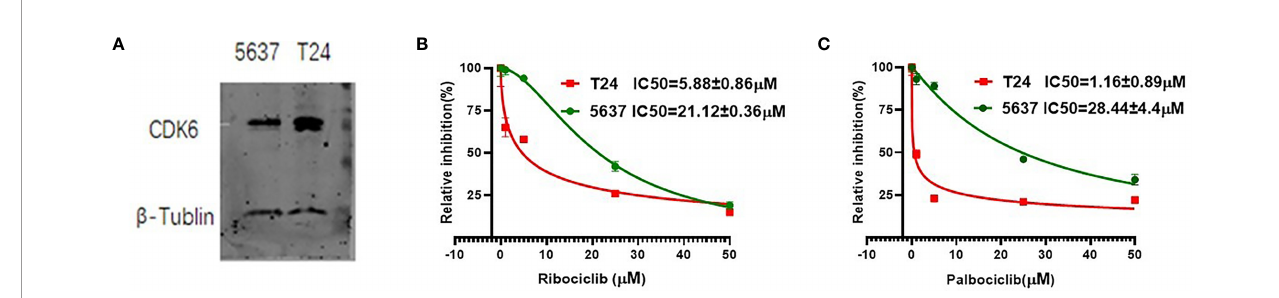
FIGURE 4 | The CDK6 protein expression and IC50 value of CDK4/6 inhibitors in urothelial carcinoma cell lines. Western blot analysis showed higher CDK6 protein expression in T24 cell lines compared to 5637 cell lines (A) . Relative growth inhibition curves of ribociclib (B) and palbociclib (C) in 5637 or T24 cell lines were from three independent experiments. Mean IC50 value of ribociclib was 21.12 ± 0.36 m M for the 5637 cells and 5.88 ± 0.86 m M for the T24 cells (p <0.001), and mean IC50 value of palbociclib was 28.44 ± 4.4 m M for the 5637 cells and 1.16± 0.89 m M for the T24 cells (p